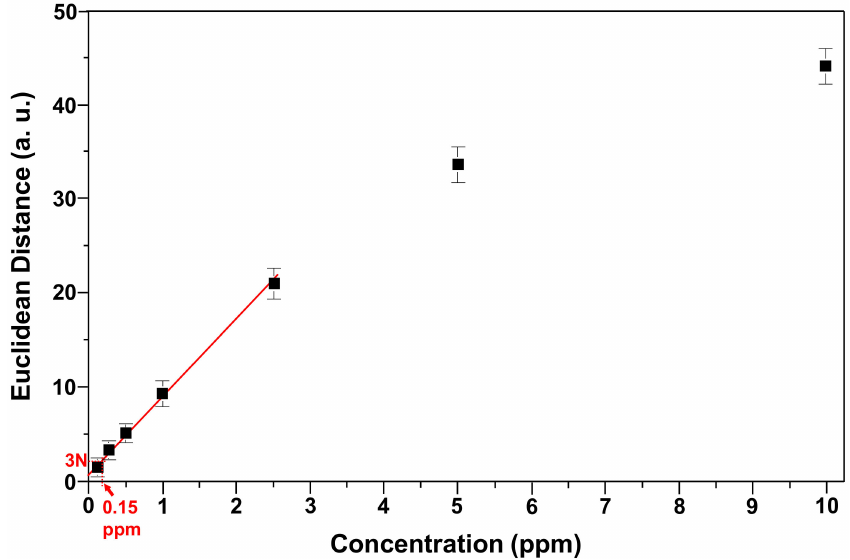
Figure 7. The calculation of the limit of detection of cyclohexanone. Data points between 0.1 and 2.5 ppm were linearly fitted and extrapolated to the concentration when signal-to-noise ratio (S/N) = 3. The limit of detection (LOD) is estimated to be ~0.15